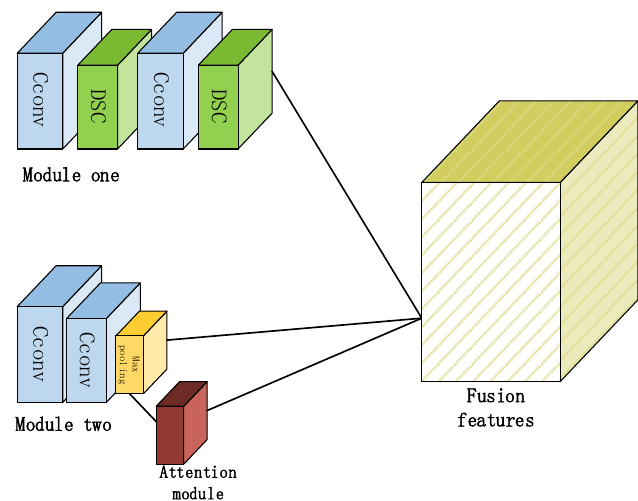
Figure 2. Two module groups and feature fusion.